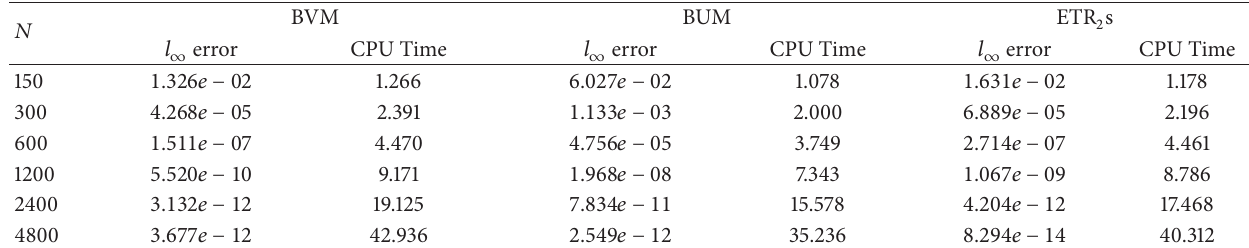
Table 3: Computational results for V = 3 for Example 5.2.